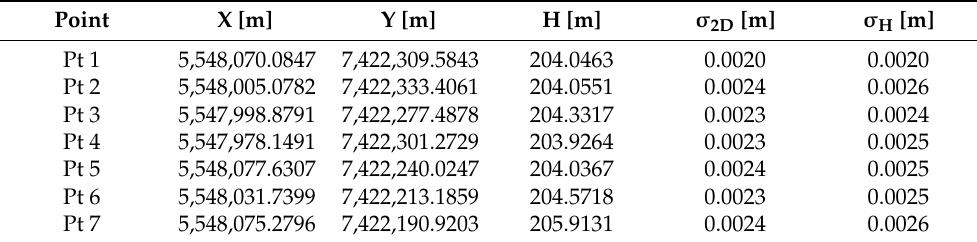
Figure 2. Sketch of measurement site on Google Maps 3D. Table 1. Reference points coordinates with position and height mean square errors.